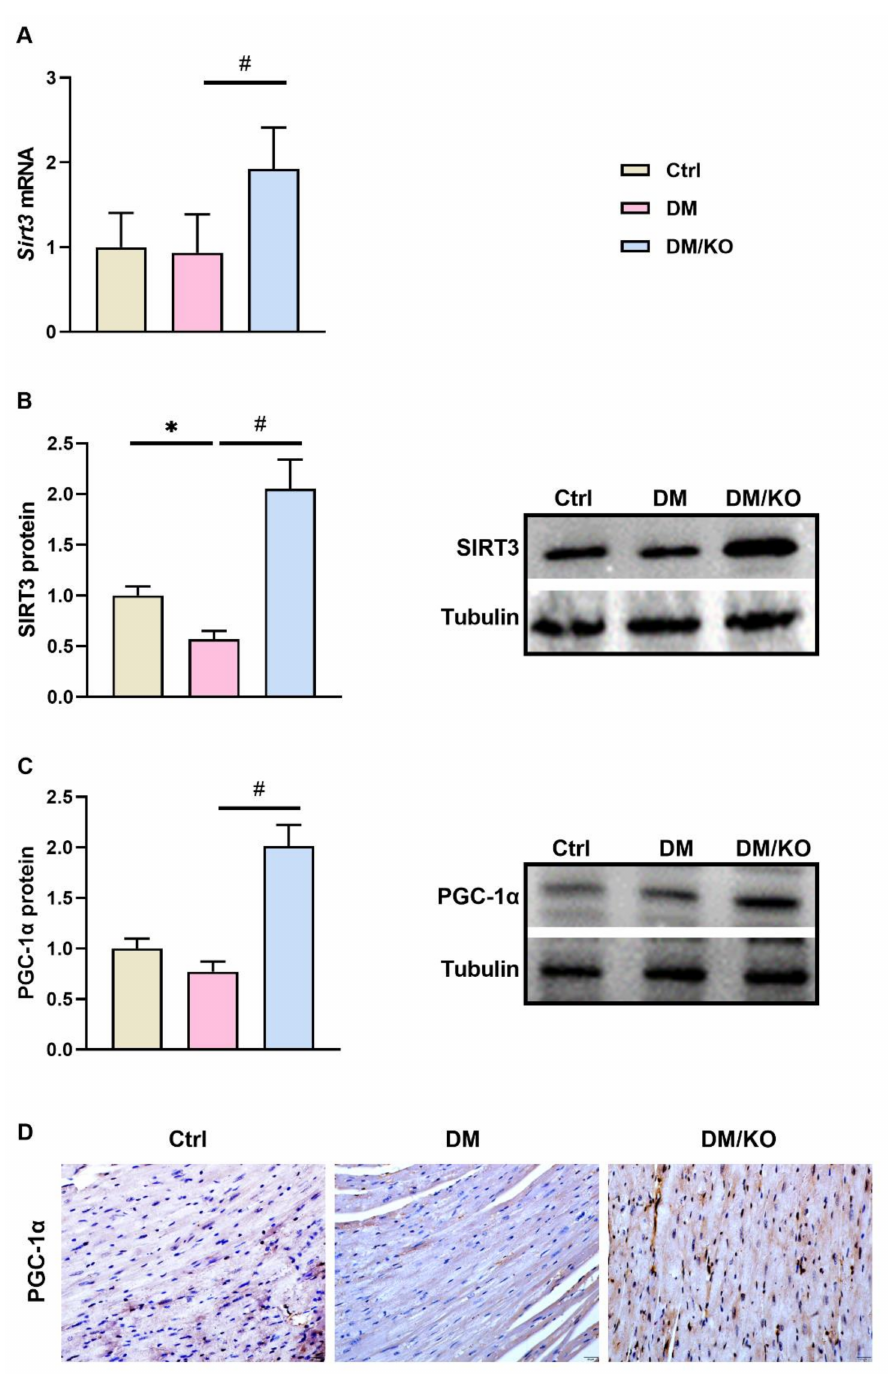
(Figure 6A,B) and protein levels of cardiac PGC1- α (Figure 6C) in the diabetic mice. IHC staining further confirmed that PGC1- α protein was reduced in the diabetic cardiomyopa- thy, whereas KO could increase cardiac PGC1- α protein expression (Figure 6D).